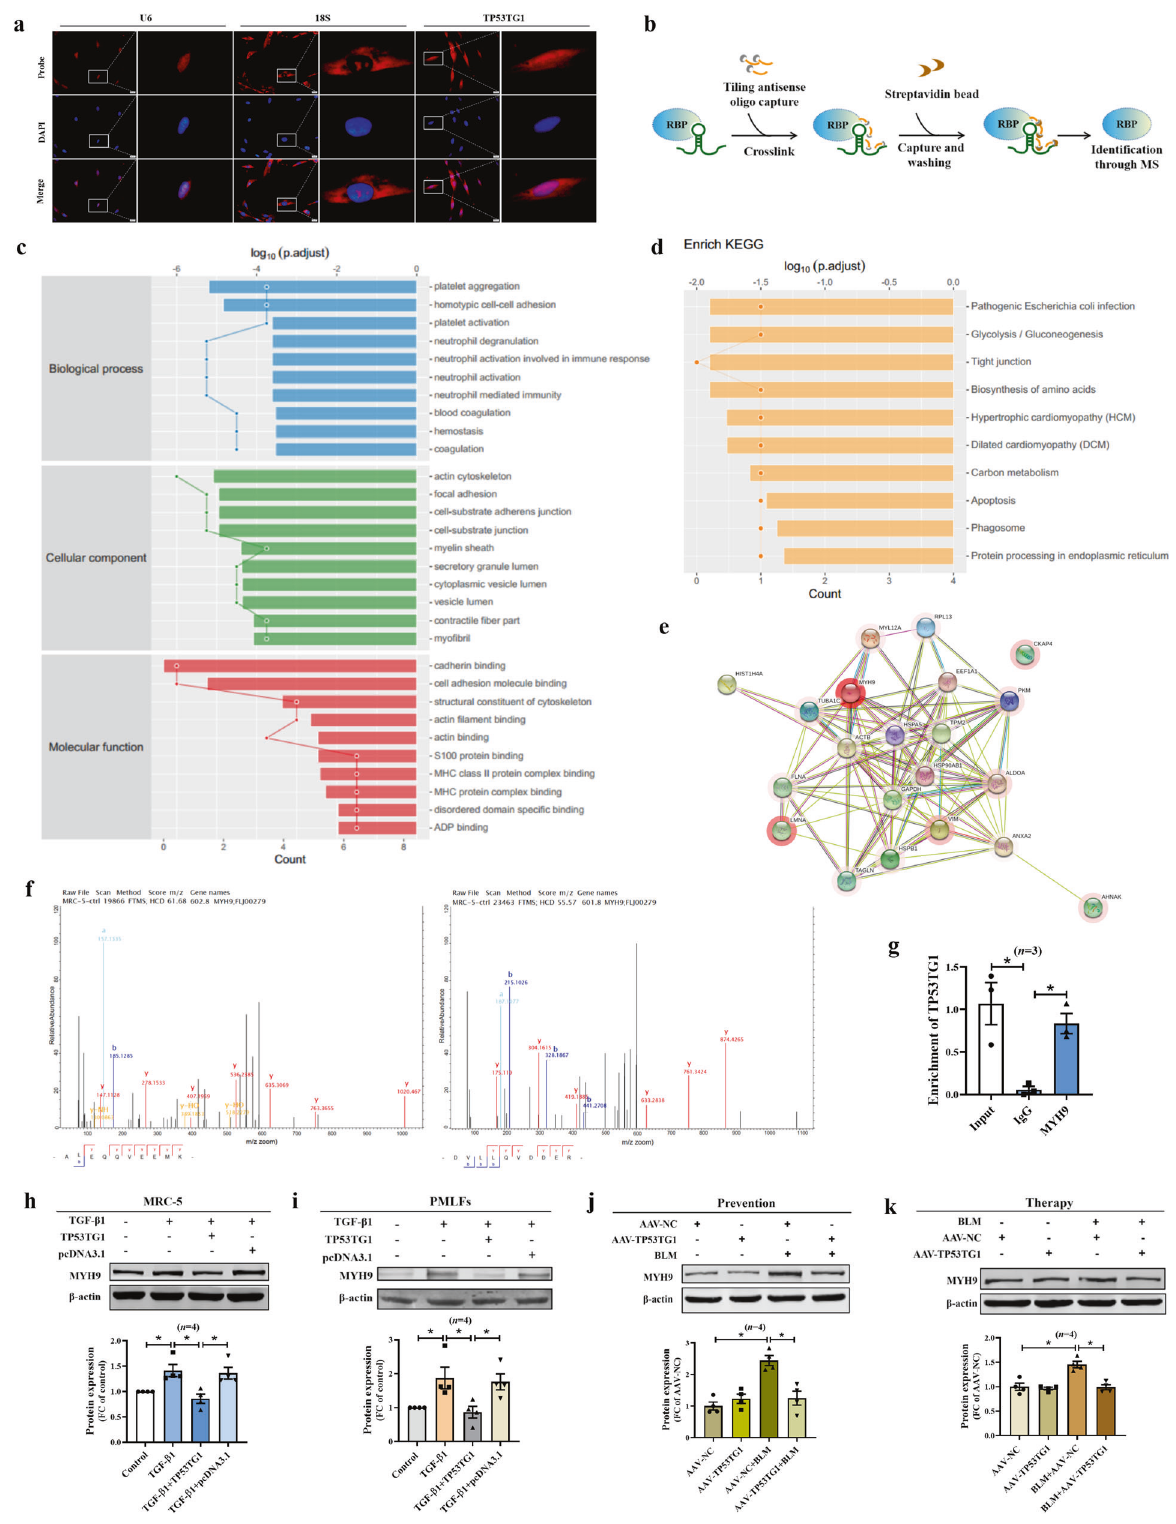
Fig. 7 TP53TG1 regulates MYH9 expression through binding to it. a The FISH probe detected that TP53TG1 was expressed in the cytosol and nucleus in MRC-5; bar = 20 μ m; n = 4. b Schematic diagram of ChIRP-MS. c , d KEGG and GO analysis of the TP53TG1 interactome demonstrated the enrichment of splicing factors among TP53TG1-interacting proteins. e The interaction network of TP53TG1 protein interactome. f The protein mass spectrum suggested the MYH9 protein may bind to the TP53TG1. g RNA-binding protein immunoprecipitation (RIP) con fi rmed the interactions between TP53TG1 and MYH9 in vitro. h TP53TG1 derepressed the MYH9 protein in MRC-5. i In PMLFs, the expression of MYH9 was reduced by TP53TG1 overexpression. j , k The protein level of MYH9 in lung tissue of AAV- TP53TG1 mice was signi fi cantly inhibited than that of BLM-treated mice. * P < 0.05. AAV-TP53TG1, adeno-associated virus 5 containing TP53TG1; FC fold change. Cell Death and Disease (2022)